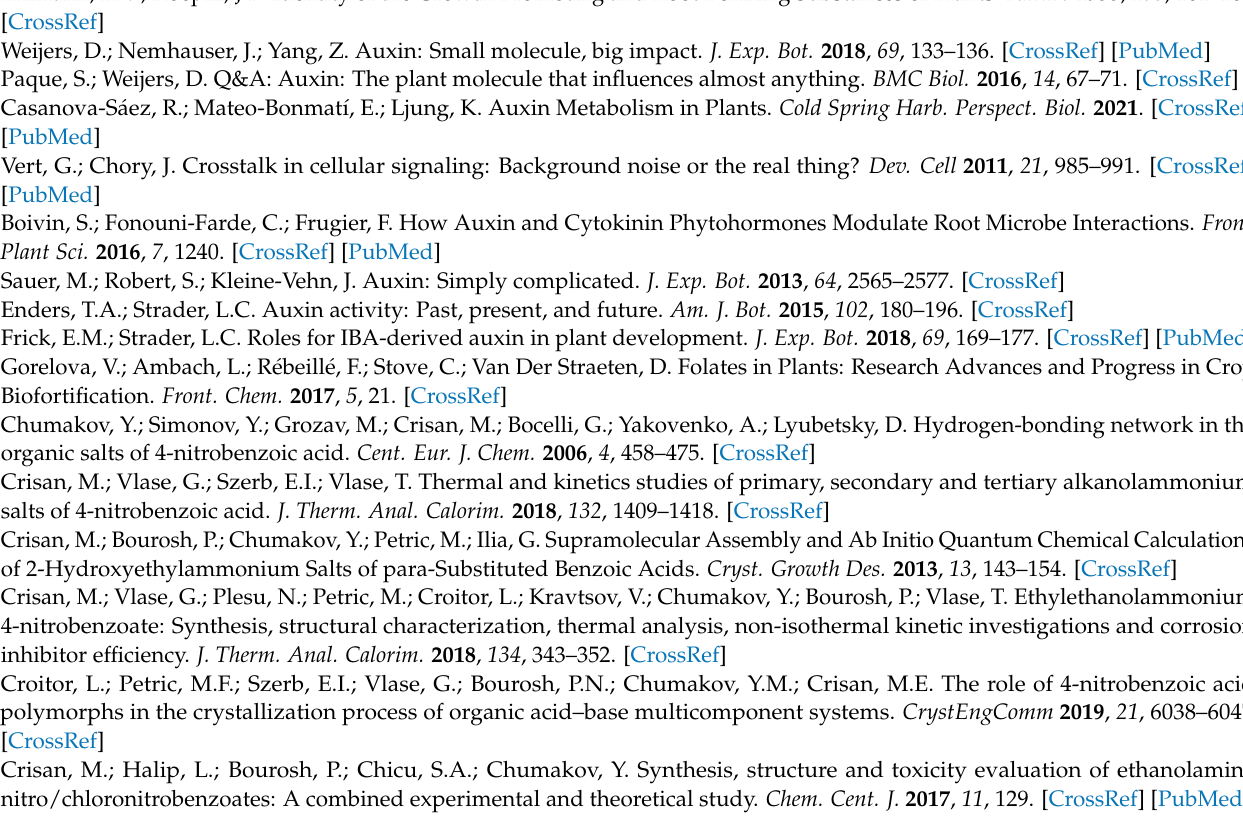
under different treatments and concentrations, Figure S2: Anion overlay of HEA- p ABA and HEA- p NBA, Figure S3: Overlay of CsTIR1 and SlTIR1 homology models. Overlay between crystallized and docked conformation of IAA in CsTIR1 and SlTIR1 binding sites, Figure S4: Overlay of IAA, HEA-pABA and HEA-pNBA in the auxin binding site of CsTIR1 and SlTIR1, Table S1: Sequence similarity and identity of CsTIR1 and SlTIR1 with AtTIR1, Table S2: Interactions of IAA in AtTIR1, CsTIR1, and SlTIR1 binding